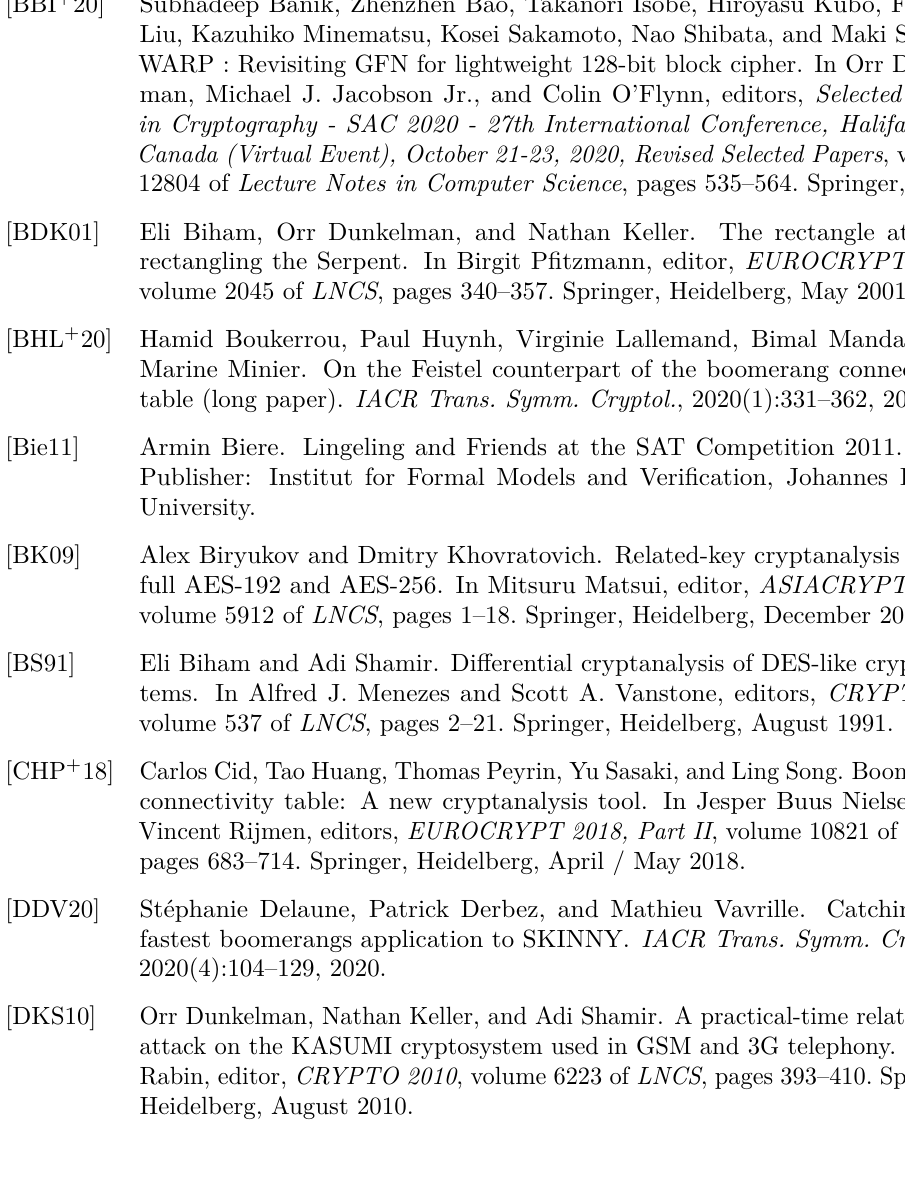
table (long paper). IACR Trans. Symm. Cryptol. , 2020(1):331–362,